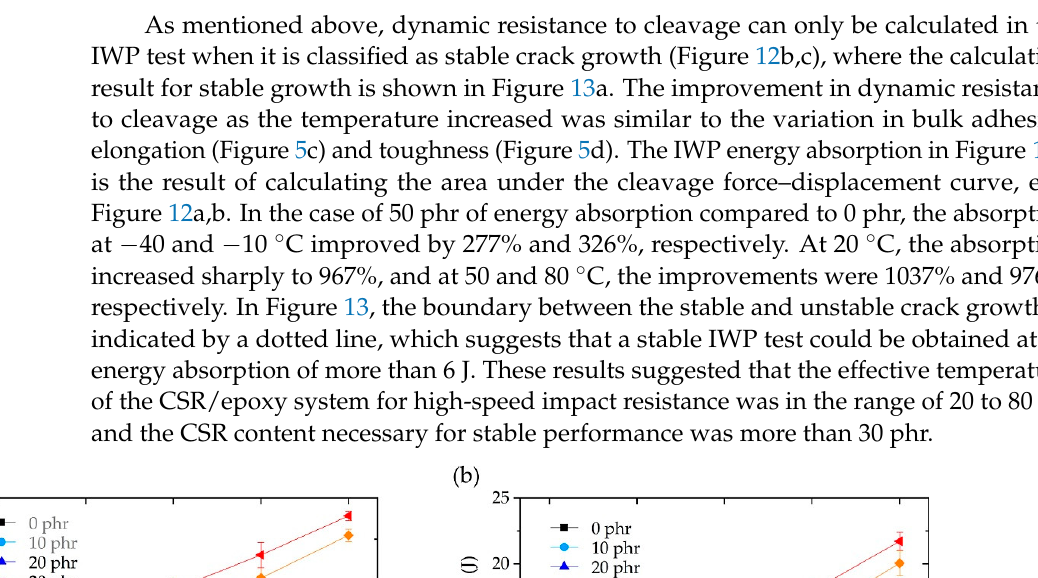
Figure 12. IWP test results depicting ( a ) unstable crack growth (0 phr @ 80 °C), ( b ) stable crack growth (50 phr @ 80 °C), and a ( c ) stable–unstable map of all compositions. Schematic illustration of the IWP specimen cleavage and deformation on a ( a’ ) brittle adhesive and a ( b’ ) ductile adhesive.